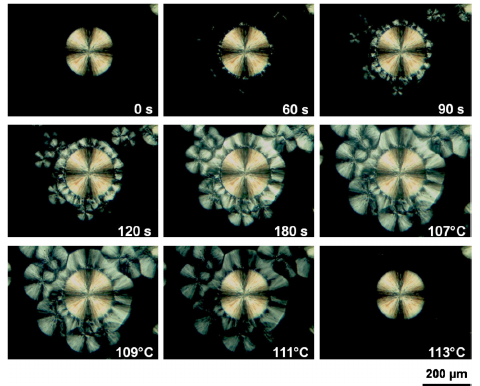
Figure 7. Optical micrographs showing the induced crystallization of a form I iPBu spherulite toward the surrounding molten part and the in situ melting process of the newly formed iPBu crystals. The pictures were taken during the isothermal crystallization process at 83 ◦ C from 0 to 120 s and the in situ heating process from 83 to 113 ◦ C. Reproduced with permission from Ref. [49], copyright 2013 Elsevier